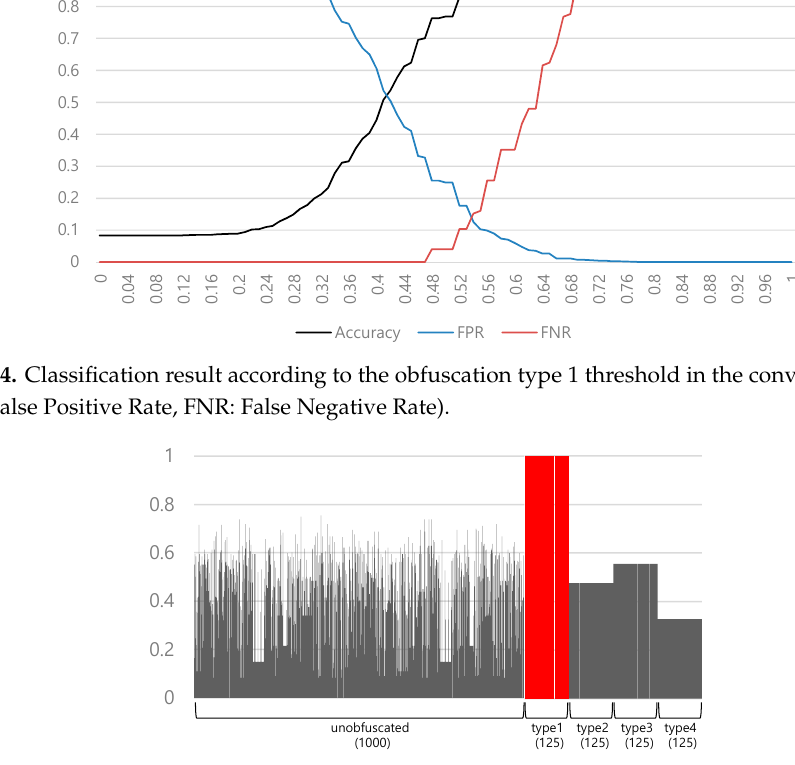
Figure 5. Structure similarity of data compared with obfuscation type 1 in a lightweight AST.